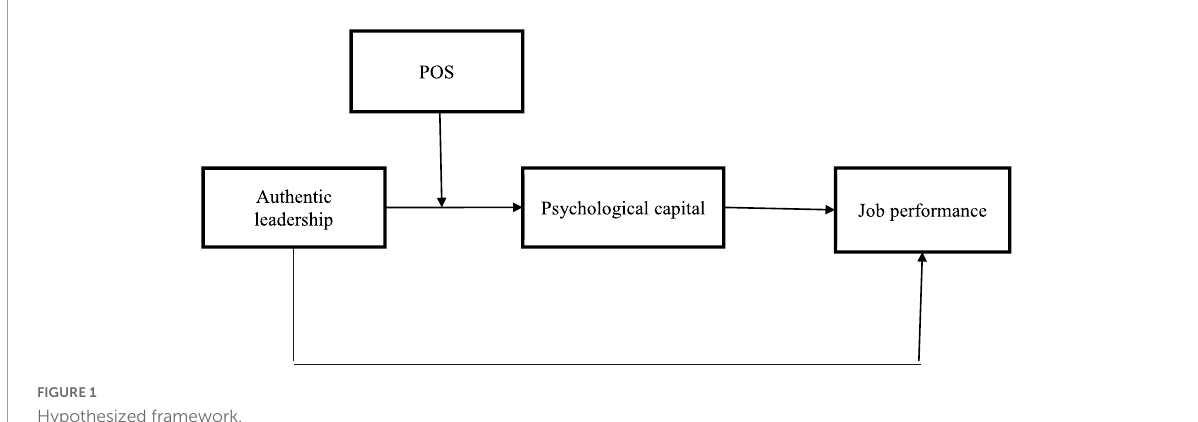
FIGURE1 Hypothesized